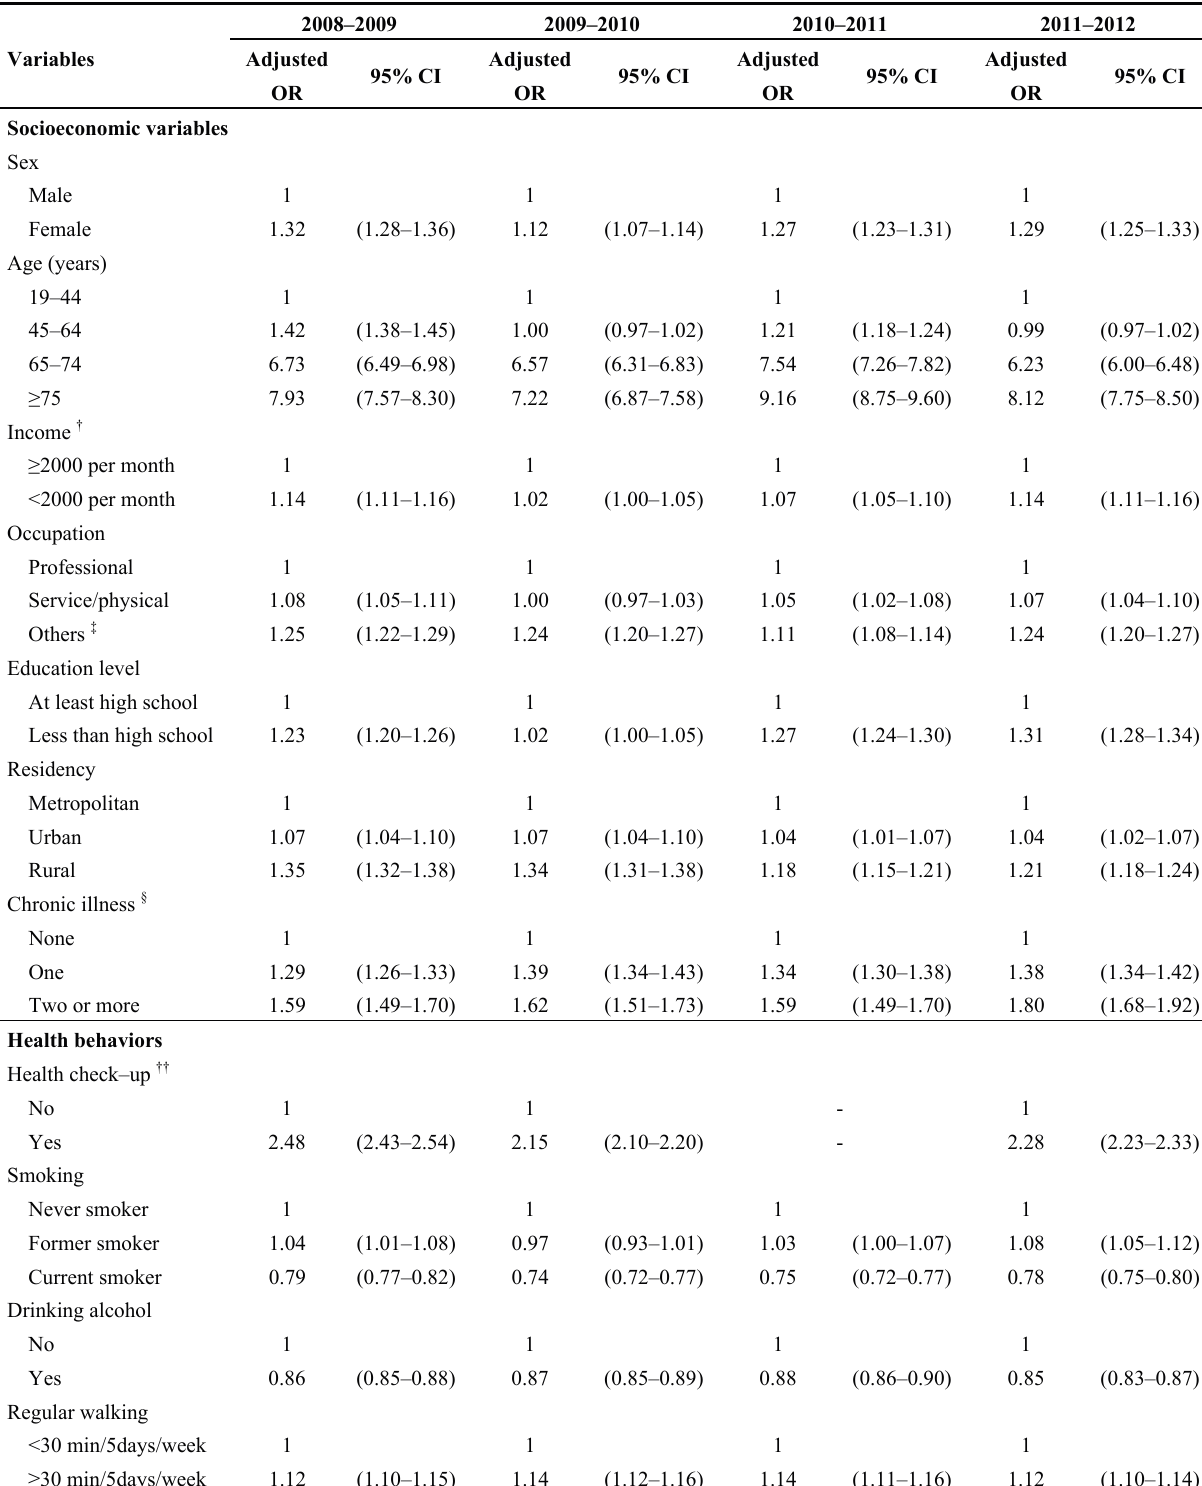
Table 3. Adjusted odds ratios of demographic characteristics associated with influenza vaccine receipt from the 2008–2009 season to the 2011–2012